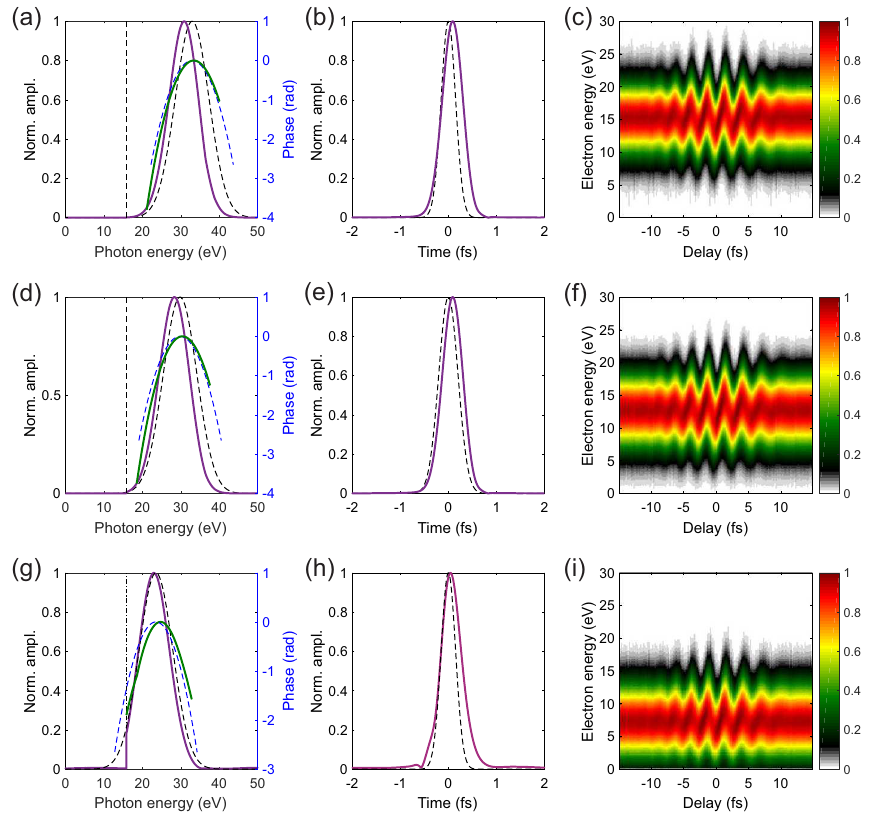
Figure 1. Theoretical simulations. ( a ) Dashed lines represent the original attosecond spectral amplitude (black) and phase (blue) for a pulse with central energy corresponding to the 21st harmonic of the infrared (IR) pulse ( ω XUV = 32.96 eV). Solid lines display amplitude (violet) and phase (green) of the corresponding calculated electron burst resulting from Ar ionization [24]. The vertical black dash-dotted line marks the position of the Ar ionization potential. ( b ) Temporal behaviour of the extreme-ultraviolet (XUV) attosecond pulse (black dashed) and the attosecond electron burst (solid violet). ( c ) Associated attosecond streaking trace. In false color it is shown the amplitude of the spectrogram Same quantities for a single attosecond pulse with central energy corresponding to the 19th harmonic at 29.82 eV and the 15th harmonic at 23.54 eV, respectively. The other calculations parameters are reported in the text. As a result of the atomic cross-section spectral filtering, the final photoelectron spectral amplitude bandwidths are: 8.95, 9.75, and 9.44 eV for the results in the first, second, and last row,